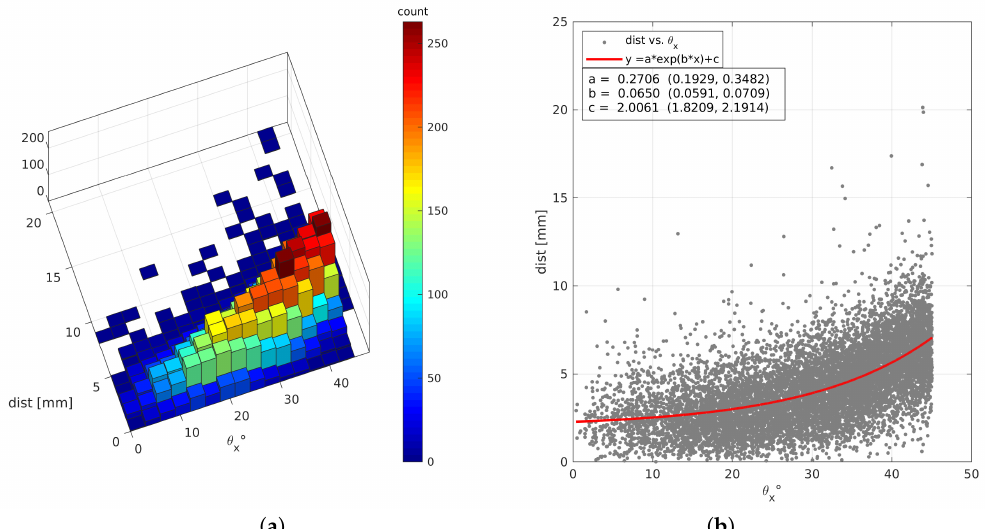
Figure 5. Distribution of the distance between muon exit point from the radiator and centroid of the 2D-Gaussian fit as a function of the angle θ x between muon direction and the normal respect to plate. The plots refer to a scenario with radiator thickness equal to 20mm and an array of 16 × 16 SiPMs; the kinetic energy of muons at the source is 10 4 MeV. Plot ( a ) is a two-dimensional histogram reported to display better the counts distribution over ( θ x , dist.) plane. Plot ( b ) includes a fit with an exponential function to suggest a possible relation between distance and θ x